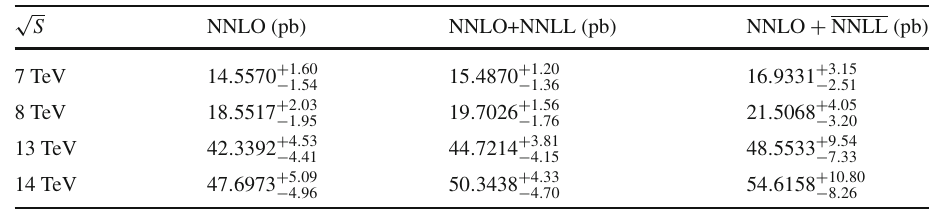
Resummed gluon fusion cross section at different centre of mass energies at the LHC. The scale uncertainty has been estimated using 7-point scale variation around the